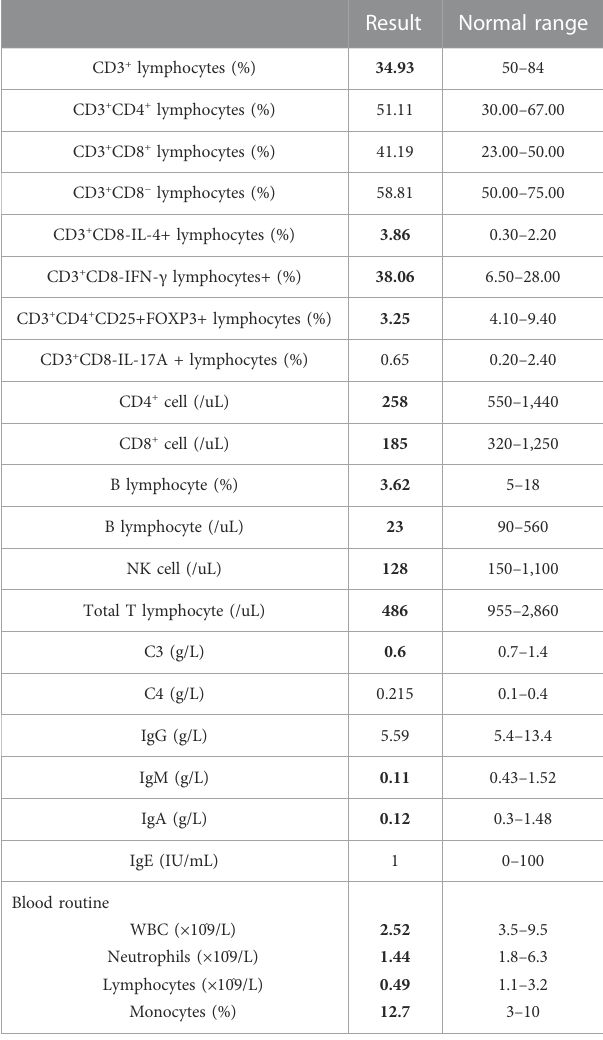
TABLE 1 Partial laboratory results of this patient.